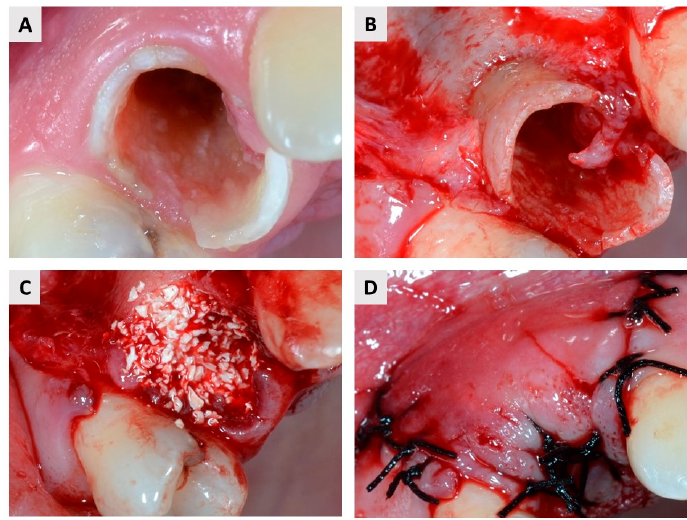
Figure 3. ( A ) Occlusal image of a hopeless premolar. ( B ) The mucoperiosteal flap was elevated be- fore tooth extraction. ( C ) Application of the cerabone ® . ( D ) Complete coverage of the biomaterials (BX and resorbable membrane) was achieved with single 5/0